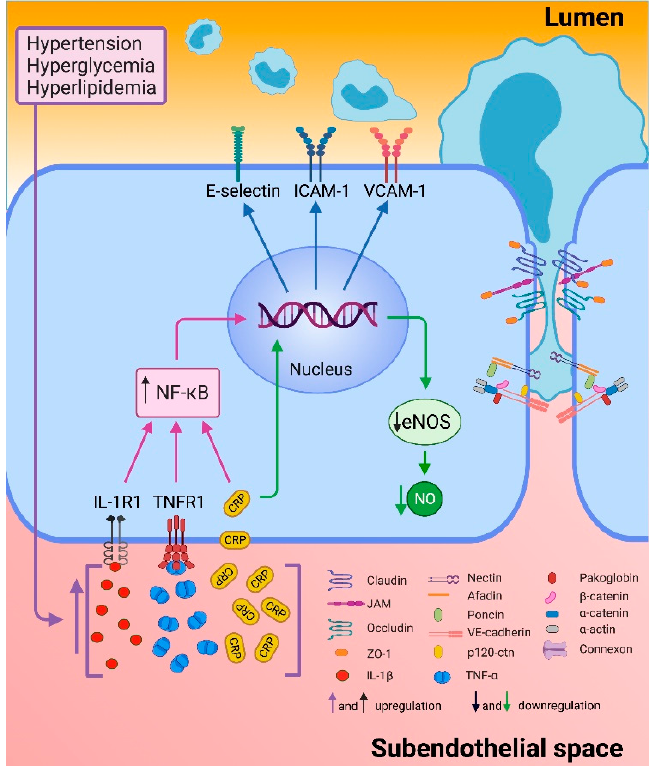
Figure 3. Endothelial inflammation. Endothelial dysfunction is triggered by different cardiovascular risk factors such as hypertension, hyperglycemia, and hyperlipidemia. These events increased production of interleukin 1 beta (IL-1 β ), tumor necrosis factor alpha (TNF- α ), and C reactive protein (CRP). Proinflammatory cytokines bind to their receptors and culminate in the activation of the nuclear transcription factor κ B (NF- κ B) that stimulate the transcription of selectin-E, intercellular adhesion molecule-1 (ICAM-1) and vascular cell adhesion molecule-1 (VCAM-1). CRP down-regulates endothelial nitric oxide synthase (eNOS) transcription and destabilizes eNOS mRNA, resulting in decreased nitric oxide (NO). Furthermore, the reorganization of actin filaments allows the opening of intercellular junctions through other signaling pathways [63,64].